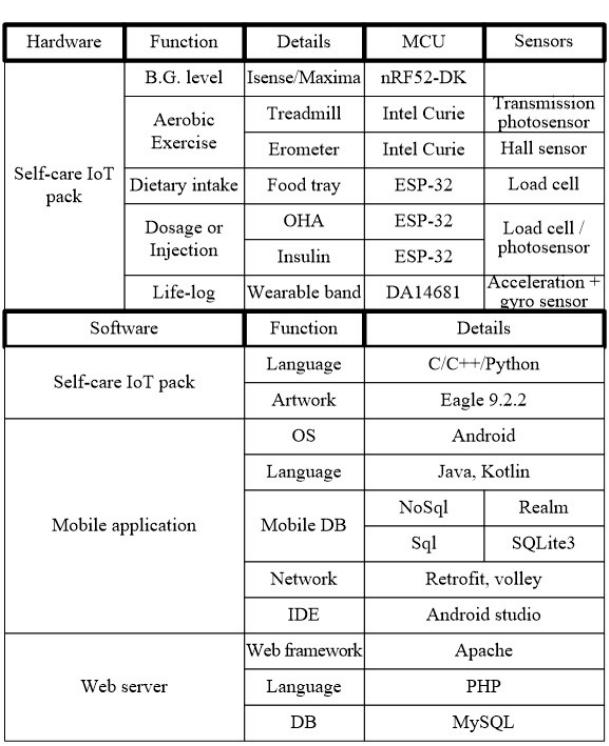
Figure 8. Summary of the proposed self-care platform.